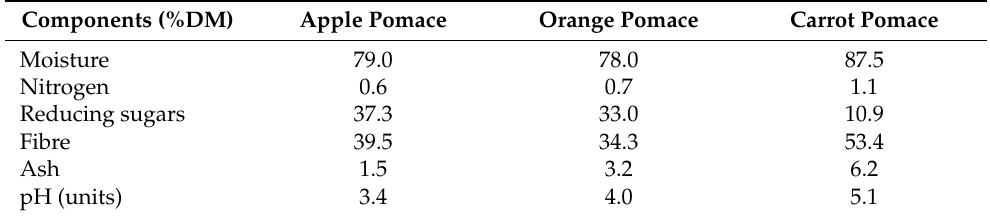
Table 1. Overall chemical composition of the three different fruit and vegetable by-products used for